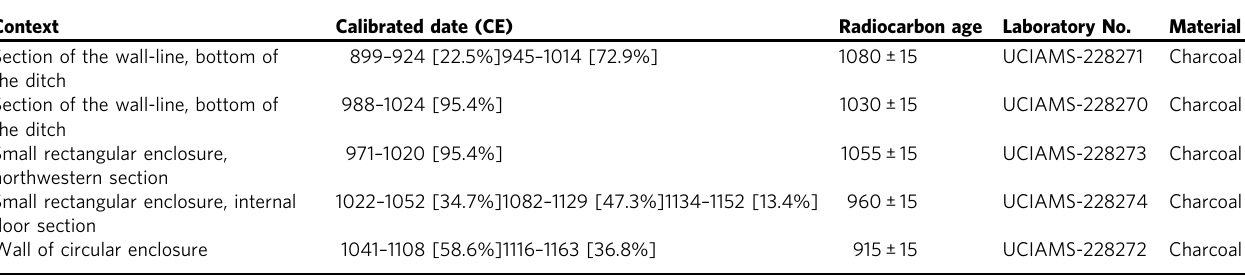
Table 1 Radiocarbon analyses of samples excavated from Cluster no. 24.